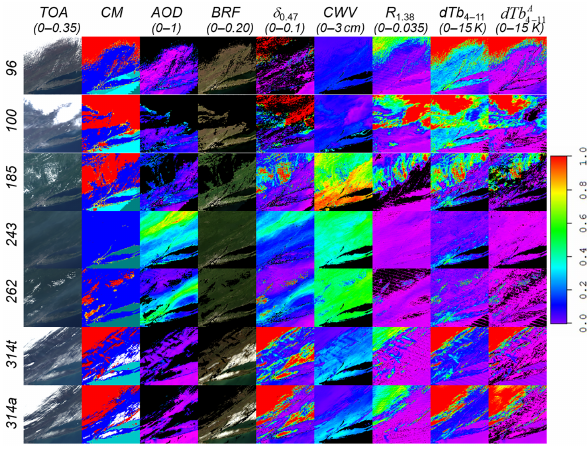
Figure 2. Illustration of MAIAC time series processing for the mid- Atlantic USA 250km region with New York City in the lower-left corner. The rows show MODIS observations for different days of the year (DOY) for 2012. The two bottom rows show DOY 314 from Terra and Aqua. The columns present the MODIS TOA RGB im- age, MAIAC products (cloud mask, AOD 0 . 47 , RGB BRF, column water vapor) and some of the internal fields used in the process- ing (deviation from clear-sky δ 0 . 47 , cirrus band reflectance R 1 . 38 , thermal contrast, dTb 4 − 11 and its atmospheric part, dTb A Columns 3, 5–9 are displayed using the rainbow palette with the (min–max) values shown in the heading in parentheses. The cloud mask uses the following legend: cloud (red), possibly cloudy (yel- low), cloud shadow (dark red), clear land (blue), clear snow (white), clear water (light blue), clear water, detected sediments (grey), glint over water (dark